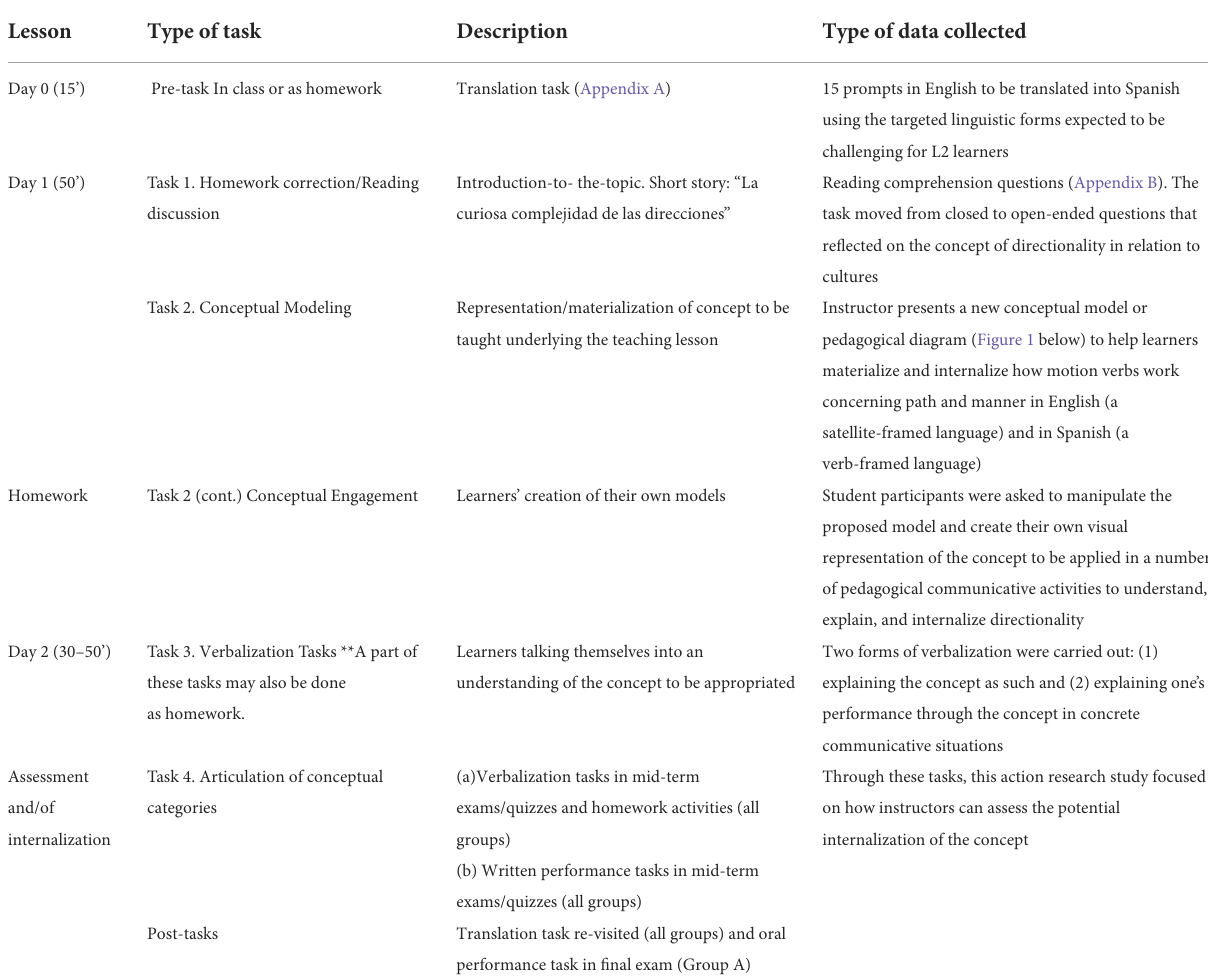
TABLE 2 Intervention timeline and